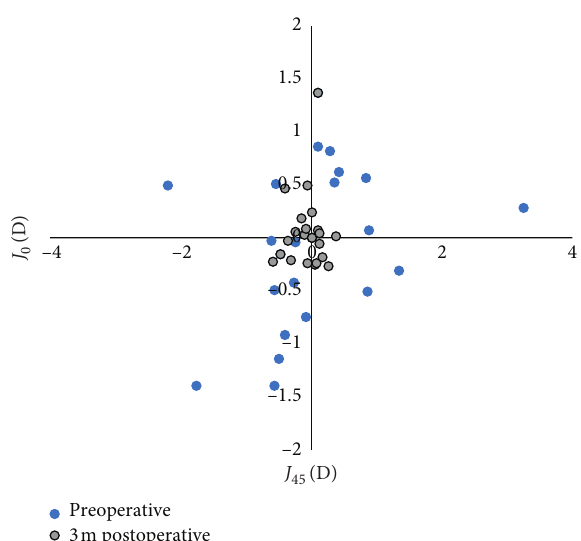
0 , J 45 ). The dots closer to the origin indicate less